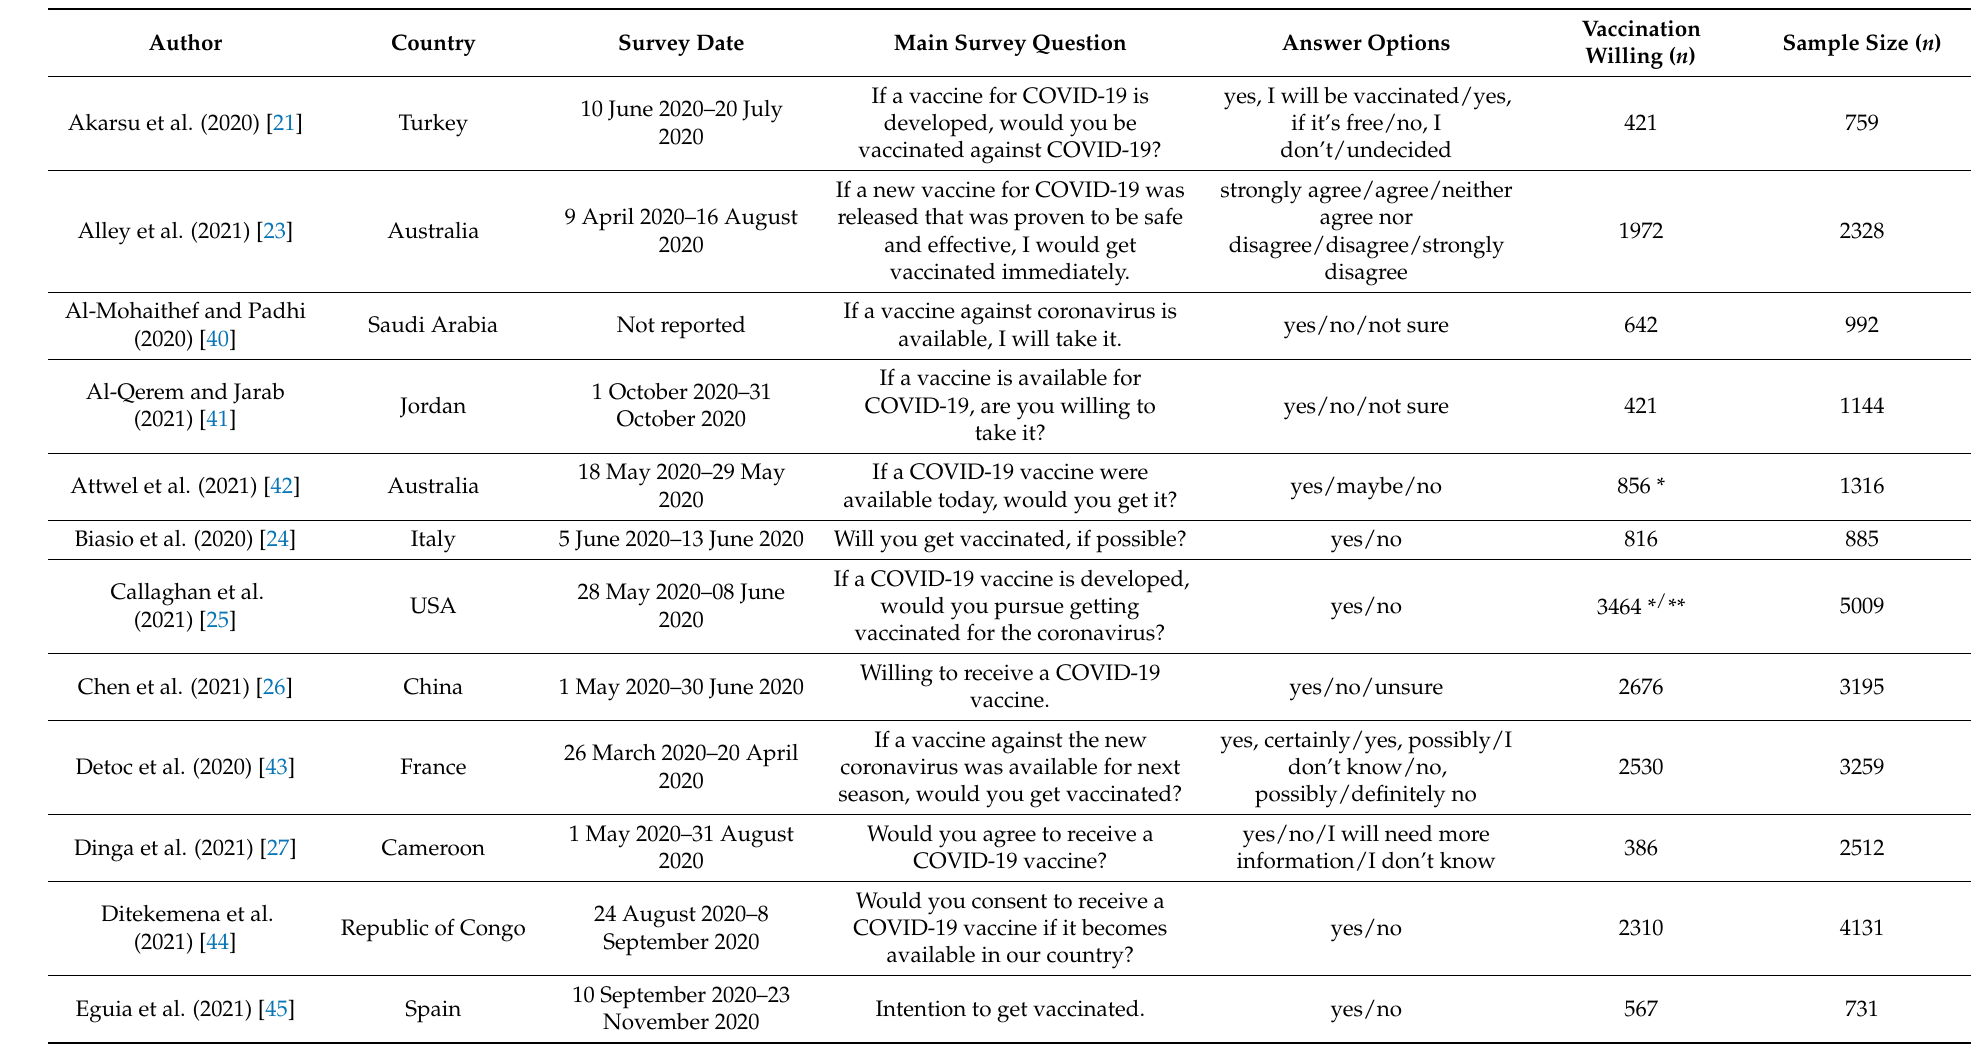
Table 3. Study characteristics of included articles in the systematic review, meta-analysis and determinant